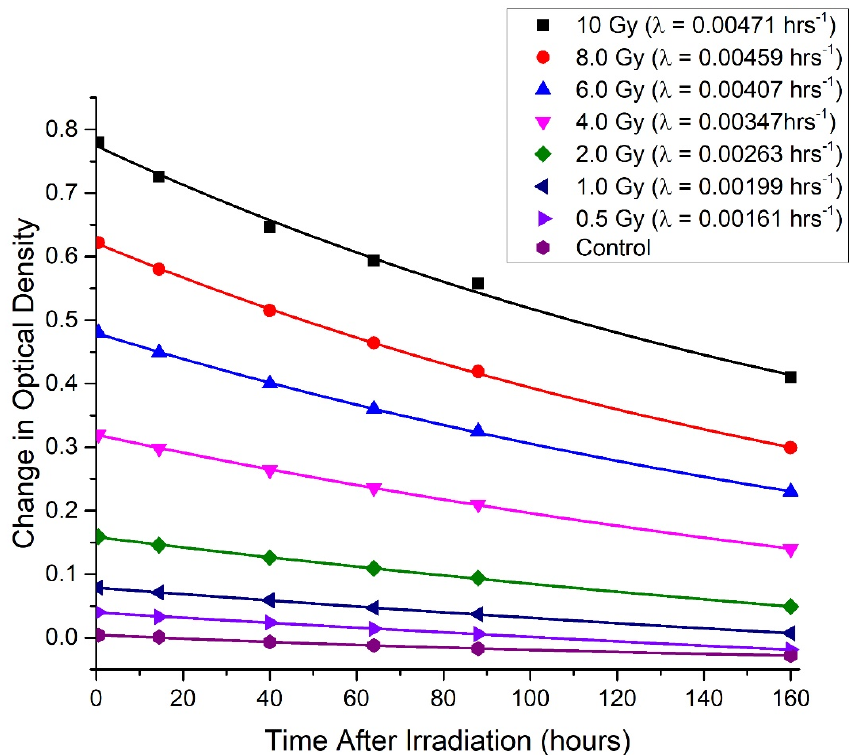
Figure 5. After initial irradiation, the clearing curves for the Formulation 2 cuvettes irradiated up to a maximum dose of 10 Gy were tracked for several days for all seven irradiated cuvettes. Fits to the curves were performed using a three-parameter fit function of the form y = y 0 + Ae −λ t .